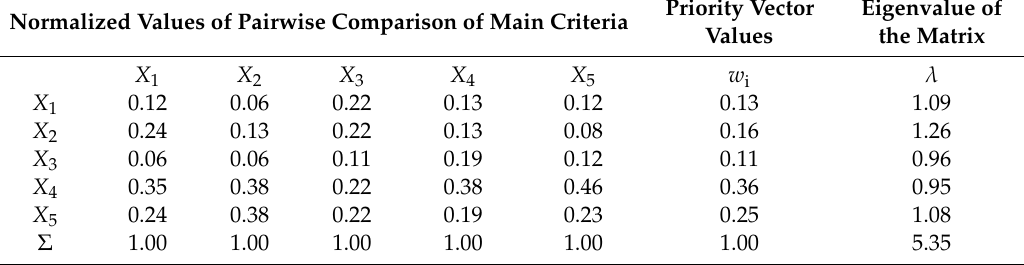
Table 10. Priority vector values and calculation correctness indicators for pair-vice comparison of main criteria.